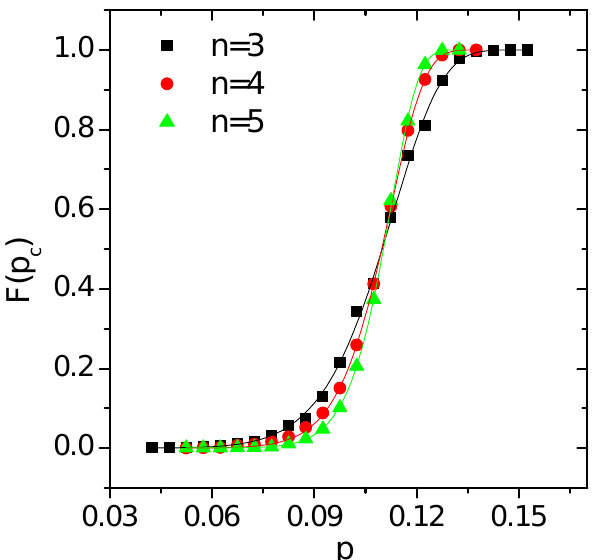
Figure 4. The empiric percolation probability function for ρ = 5 ellipsoids inside cells of different sizes (symbols); Weibull probability distribution functions(solid